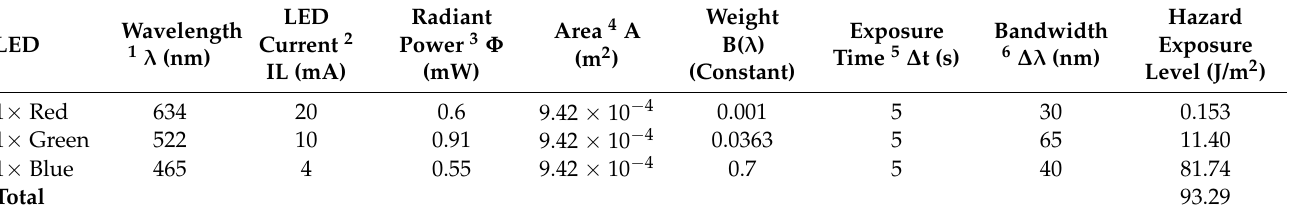
Table 2. Total retinal blue hazard exposure calculation of a single RGB LED.